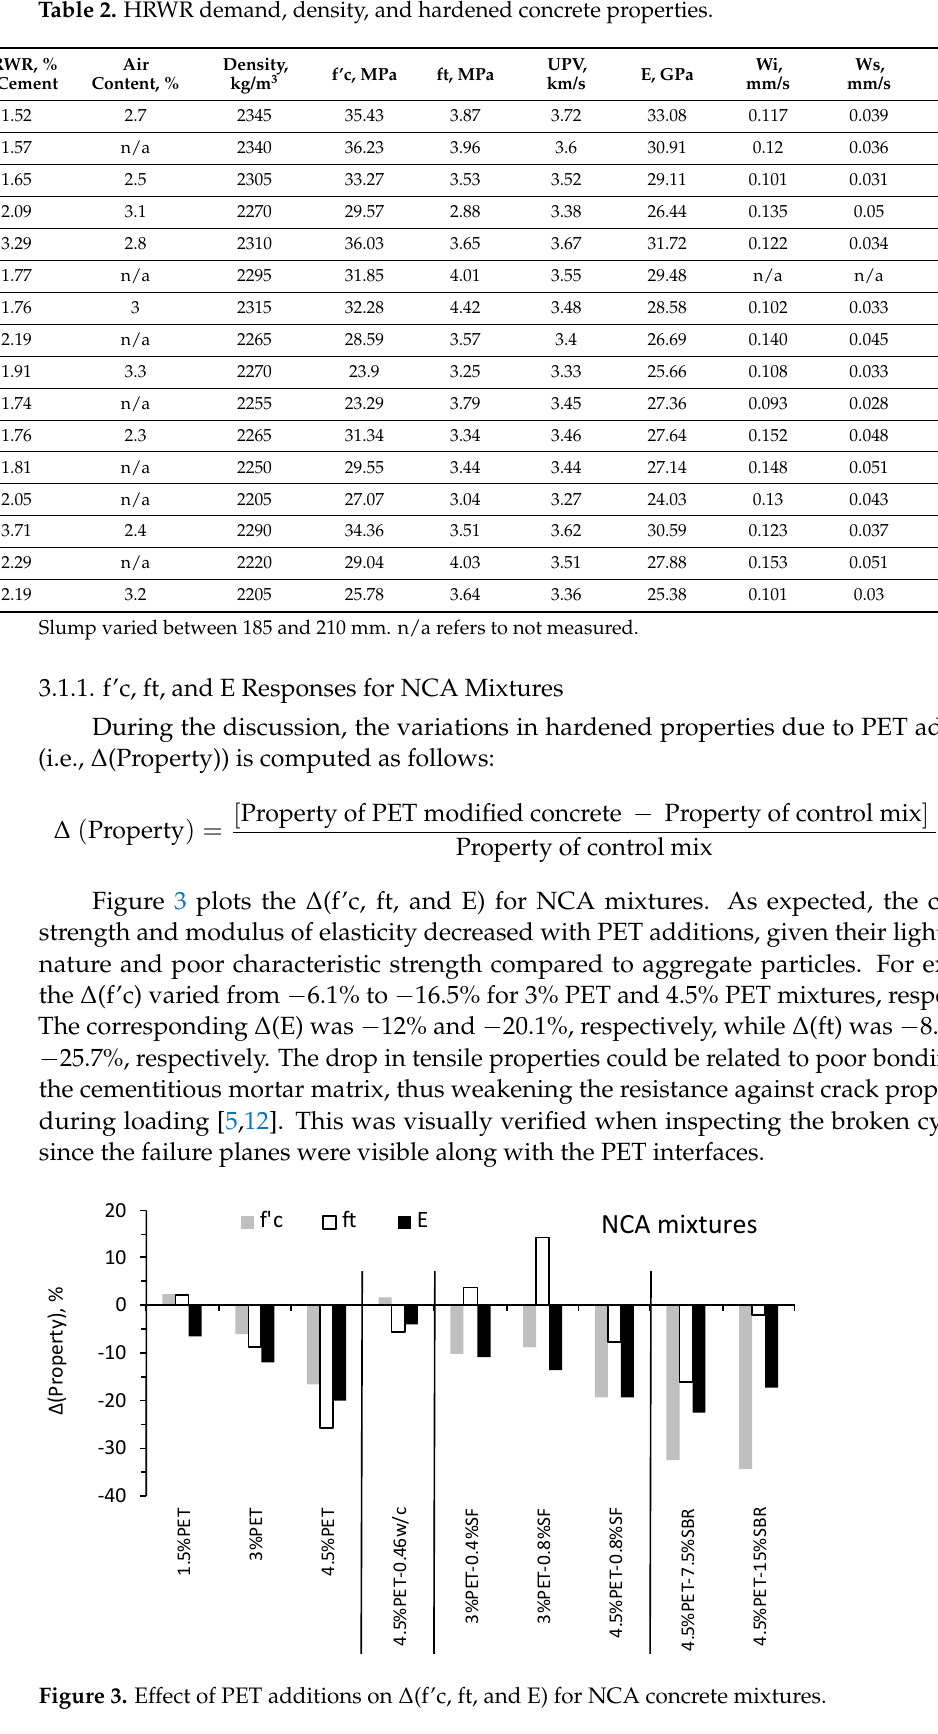
Table 2. HRWR demand, density, and hardened concrete properties.